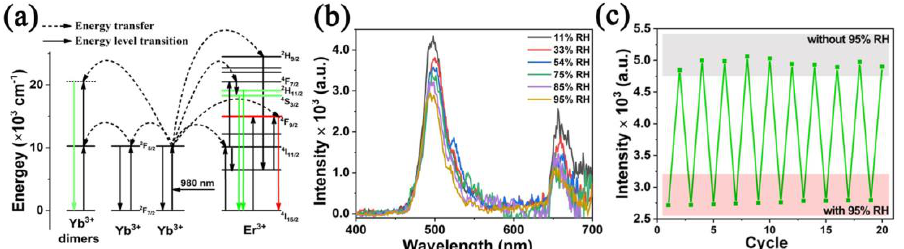
Figure 14. ( a ) Schematic energy − level diagram of Y/Yb/Er − MOF with the possible energy transfer paths. ( b ) Luminescent spectra ( λ ex = 980 nm, 1.5 W) of Y/Yb/Er − MOF − based sensor to humidity in the range of 11–95% RH. ( c ) Cycling stability of Y/Yb/Er − MOF − based sensor. Reproduced with permission from Ref. [129]. Copyright 1996–2022, MDPI, Basel,